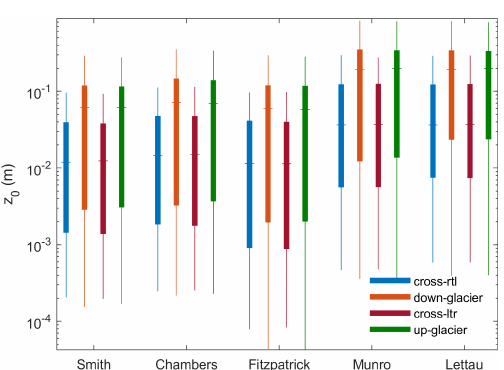
Figure 6. Boxplot visualisation of sub-grid z 0 values for all four wind directions and each applied model determined on Fridtjovbreen. The wind direction is either down-glacier (orange), up-glacier (green), cross-glacier from right to left (blue; rtl) or cross-glacier from left to right (red; ltr). Whiskers are visualising the variability outside the upper and lower quartiles up to 1.5 times the interquartile